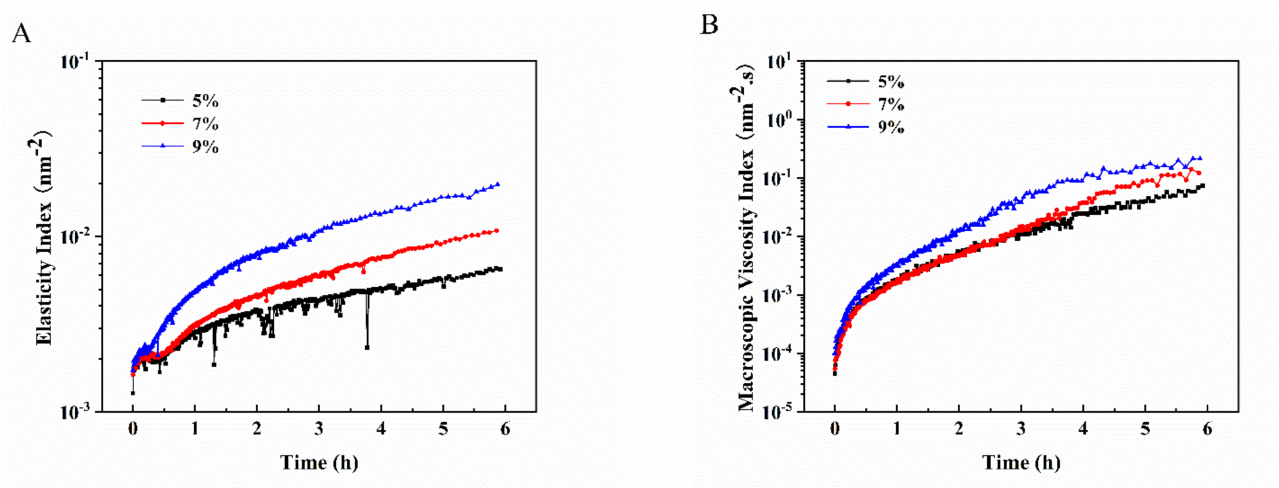
Figure 7. The EI ( A ) and MVI ( B ) of the Pickering emulsion gels developed by sorghum flour at ϕ = 70% and c = 5, 7 and